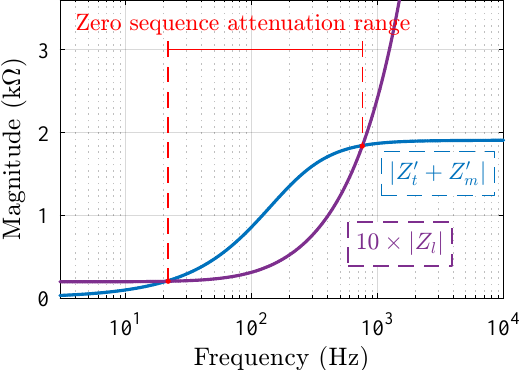
Figure 9. Evaluation of the zero sequence attenuation range for RL loads ( | Z l | = Z base and PF = 0.8). Analysis for S x opened: attenuation range between 21 Hz and 753 Hz.